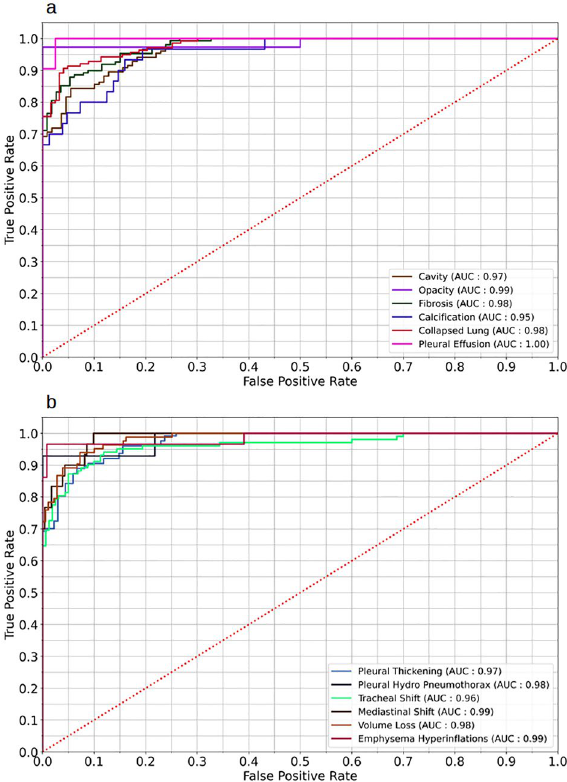
Figure 1. Receiver operating characteristic of lung wise abnormalities. ( a ) Area under receiver operating characteristic (AUC) of cavity, opacity, fibrosis, calcification, collapsed lung, pleural effusion. ( b ) AUC of pleural thickening, pneumo/hydropneumothorax, tracheal shift, mediastinal shift, volume loss, emphysema